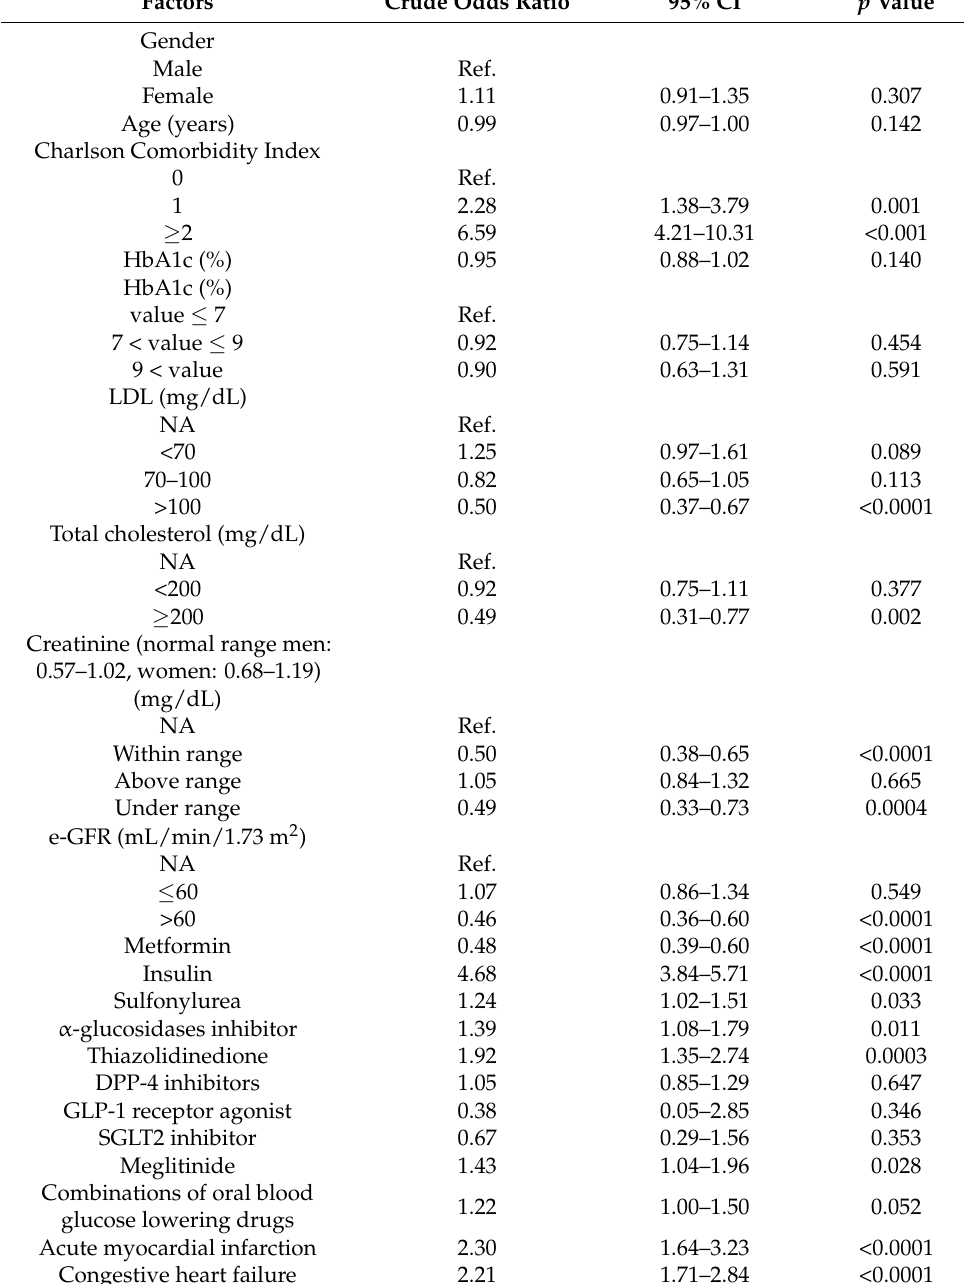
Table 3. Univariable logistic regression analysis of clinical characteristics, antidiabetic medications, and comorbidities among patients with and without hypoglycemic